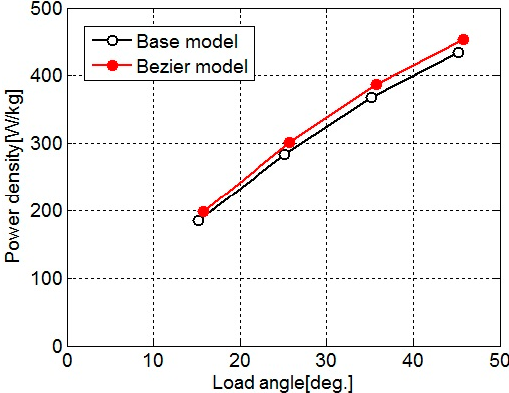
Figure 8. Power density for the load angle of the base model and Bezier model.